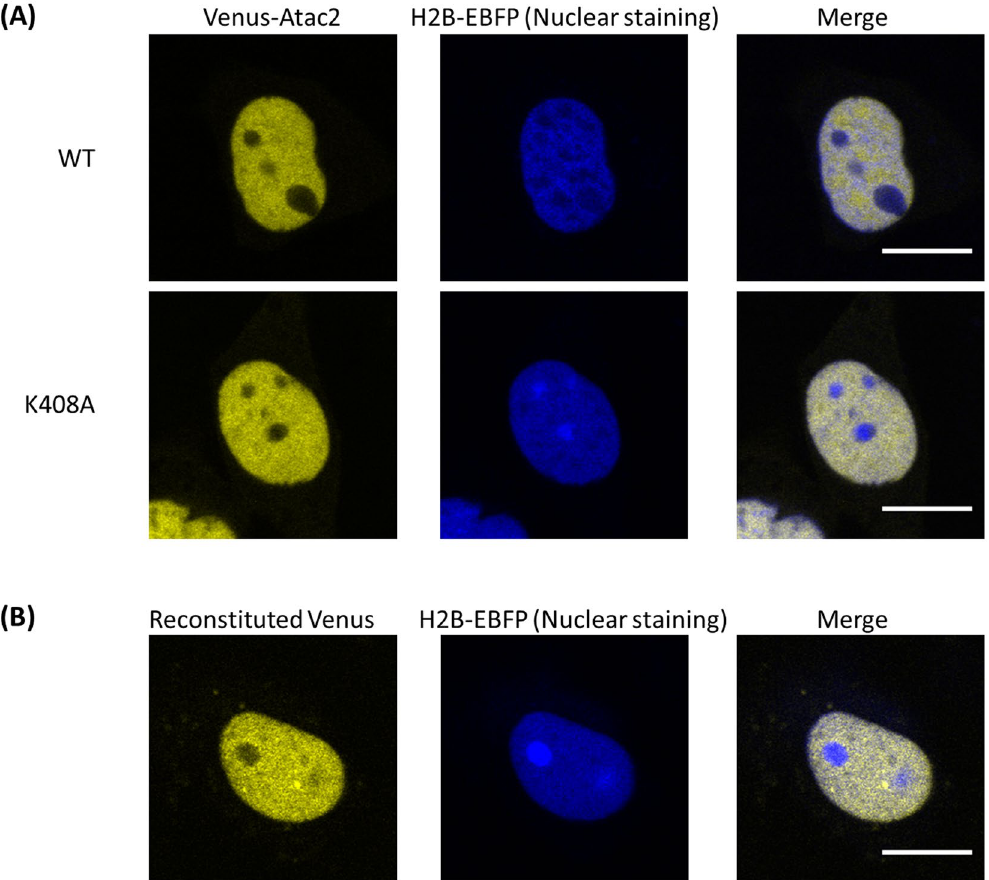
Figure 6. Subcellular localization of the SUMOylated Atac2. Fluorescence images were obtained from NIH3T3 cells expressing either Venus-fused wild-type or mutant K408A Atac2 co-expressed with H2B-EBFP ( A ) and from VN-SUMO2 stable cell lines co-expressing VC-Atac2 and H2B-EBFP ( B ). Scale bar: 10 μ